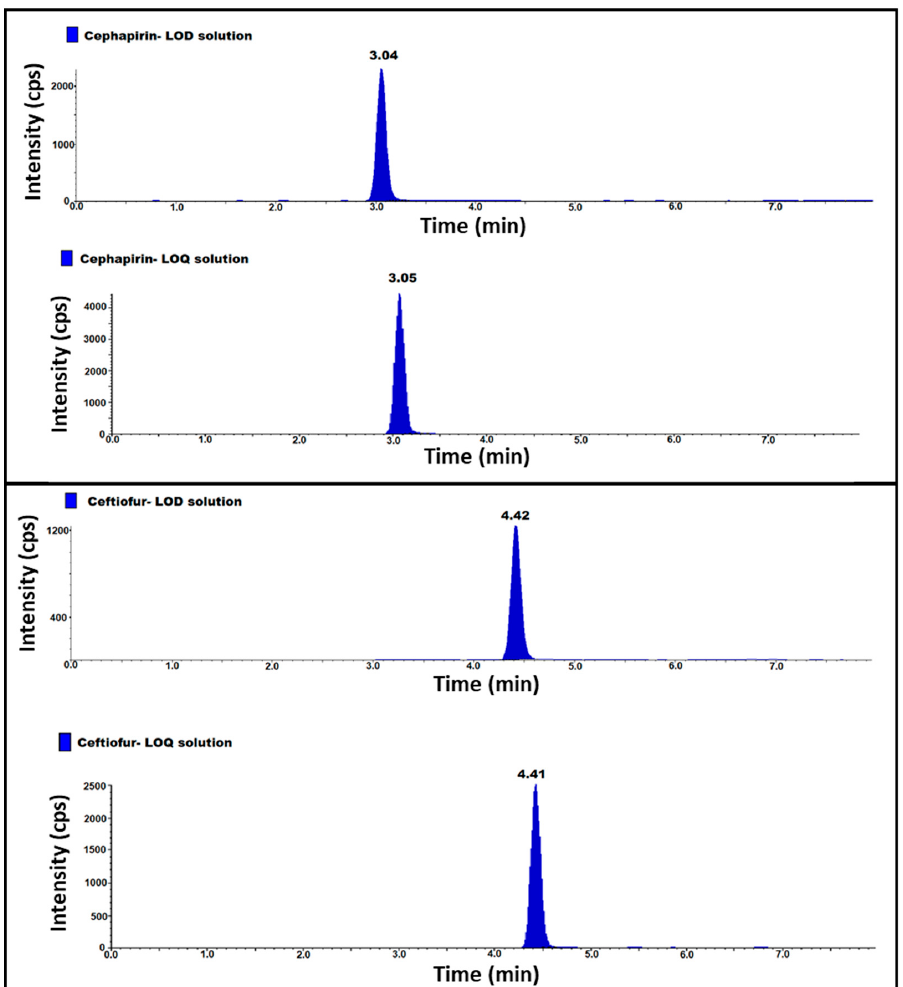
Figure 3. MS/MS LOD and LOQ chromatogram of cephapirin and ceftiofur standard solutions.